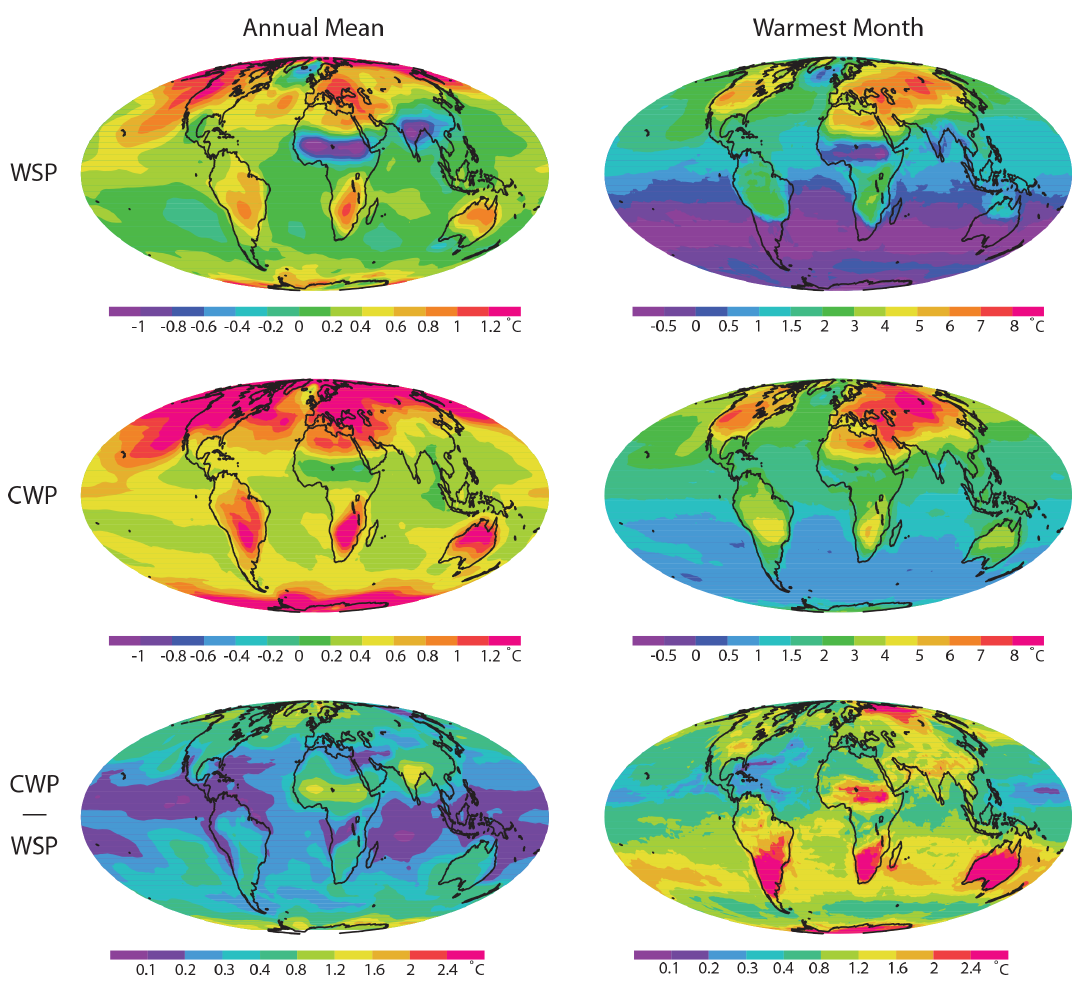
Figure 4. Spatial differences in quantified overestimation of LIG maximum temperatures for annual mean and warmest month temperatures. Map of MMM LIG maximum temperature anomalies ( ◦ C) compared to pre-industrial for the warmest-single-period (WSP, top row), the compilation-warmest-periods (CWP, middle row) and the difference between the two methods (CWP–WSP, bottom row). Maps are presented for both simulated annual mean and warmest month temperatures. Warmest-single-period results shown here are based on the globally averaged single-warmest-period. Note the differences and the non-linearity in the colour